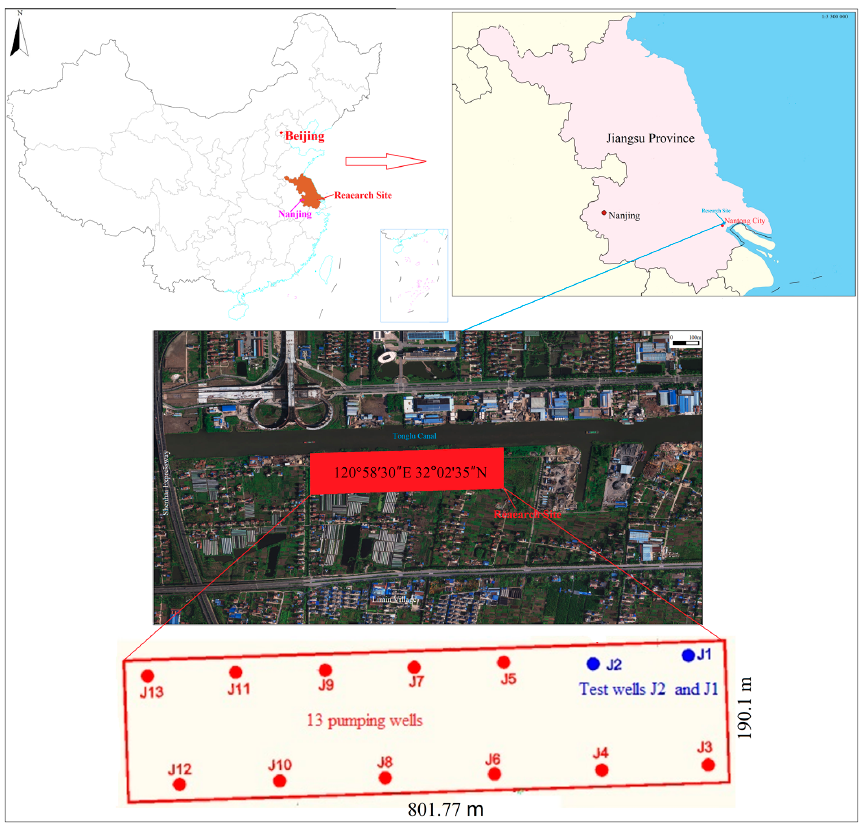
Figure 1. Location of study area and pumping wells.